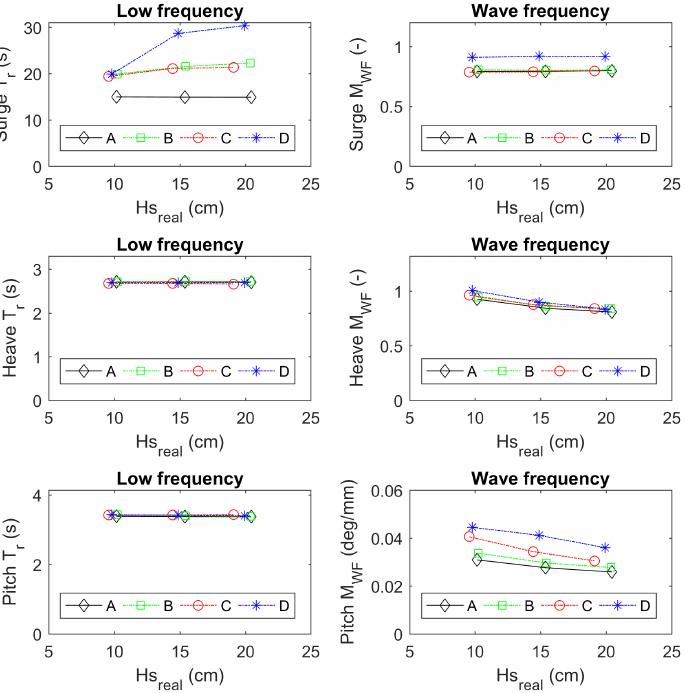
Figure 20. Metrics T r (left column) and M WF (right column) applied to surge (top row), heave (middle row), and pitch (bottom row) motions for realised significant wave height ( H s JONSWAP T p = 2.58 s, H s = 10 cm, 15 cm, and 20 cm sea-states per